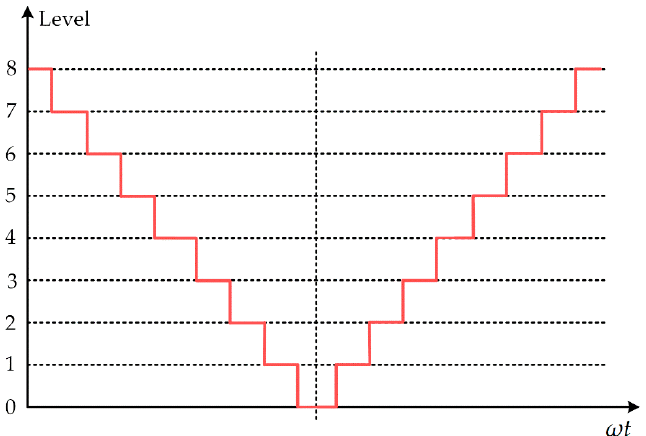
Figure 10. The output-phase voltage of the 2 N +1 modulation method. Table 2. The relationship between the total number of switched-in sub-modules and the output-phase voltage level.